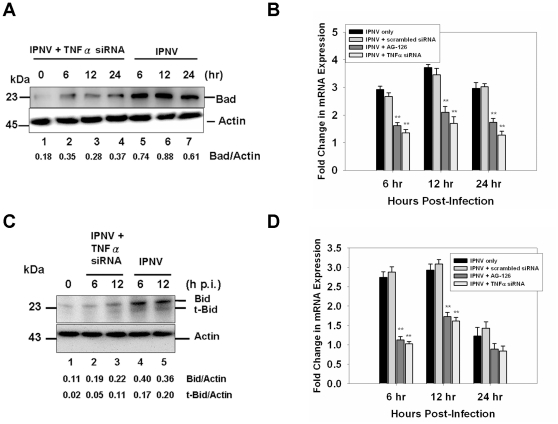
A TNFα-mediated death signal regulates the expression of pro-apoptotic Bad and Bid in IPNV-infected ZF4 cells during the early-middle stage of replication.(A) The expression level of the pro-apoptotic proteins Bad and Bid in IPNV-infected ZF4 cells (MOI = 1) at 0, 6, 12, and 24 h p.i. was determined. The proteins were detected using western blot with a polyclonal antibody specific for mouse Bad. Lanes 1–4: ZF4 cells were pretreated with TNFα-specific siRNA and infected with IPNV for 0 (lane 1), 6 (lane 2), 12 (lane 3), or 24 h (lane 4). Lanes 5–7: untreated ZF4 cells were infected with IPNV for 6 (lane 5), 12 (lane 6), or 24 h (lane 7). The expression of actin was used as an internal control. Results are expressed as the ratio of Bad/actin. The mRNA expression of bad (B) and bid (D) in IPNV-infected ZF4 cells was quantified using quantitative RT-PCR. ZF4 cells were pre-treated with TNFα-specific siRNA or AG-126 and infected with IPNV (MOI = 1) for 0, 6, 12, or 24 h. The expression of ef1a was used as an internal control. Data shown are mean ± SD. Student's t tests indicate significant differences compared to untreated control: **, p<0.01. (C) The expression level of the pro-apoptotic proteins Bid and t-Bid in IPNV-infected ZF4 cells (MOI = 1) at 0, 6 and 12 h p.i. was determined. The proteins were detected using western blot with a polyclonal antibody specific for Bid. Lanes 2–3: ZF4 cells were pretreated with TNFα-specific siRNA and infected with IPNV for 6 (lane 2) or 12 h (lane 3). Untreated ZF4 cells were infected with IPNV for 6 (lane 4) or 12 h (lane 5). Untreated ZF4 cells were infected with IPNV for 0 h (Lane 1). The expression of actin was used as an internal control. Results are expressed as the ratio of Bid/actin or t-Bid/actin.